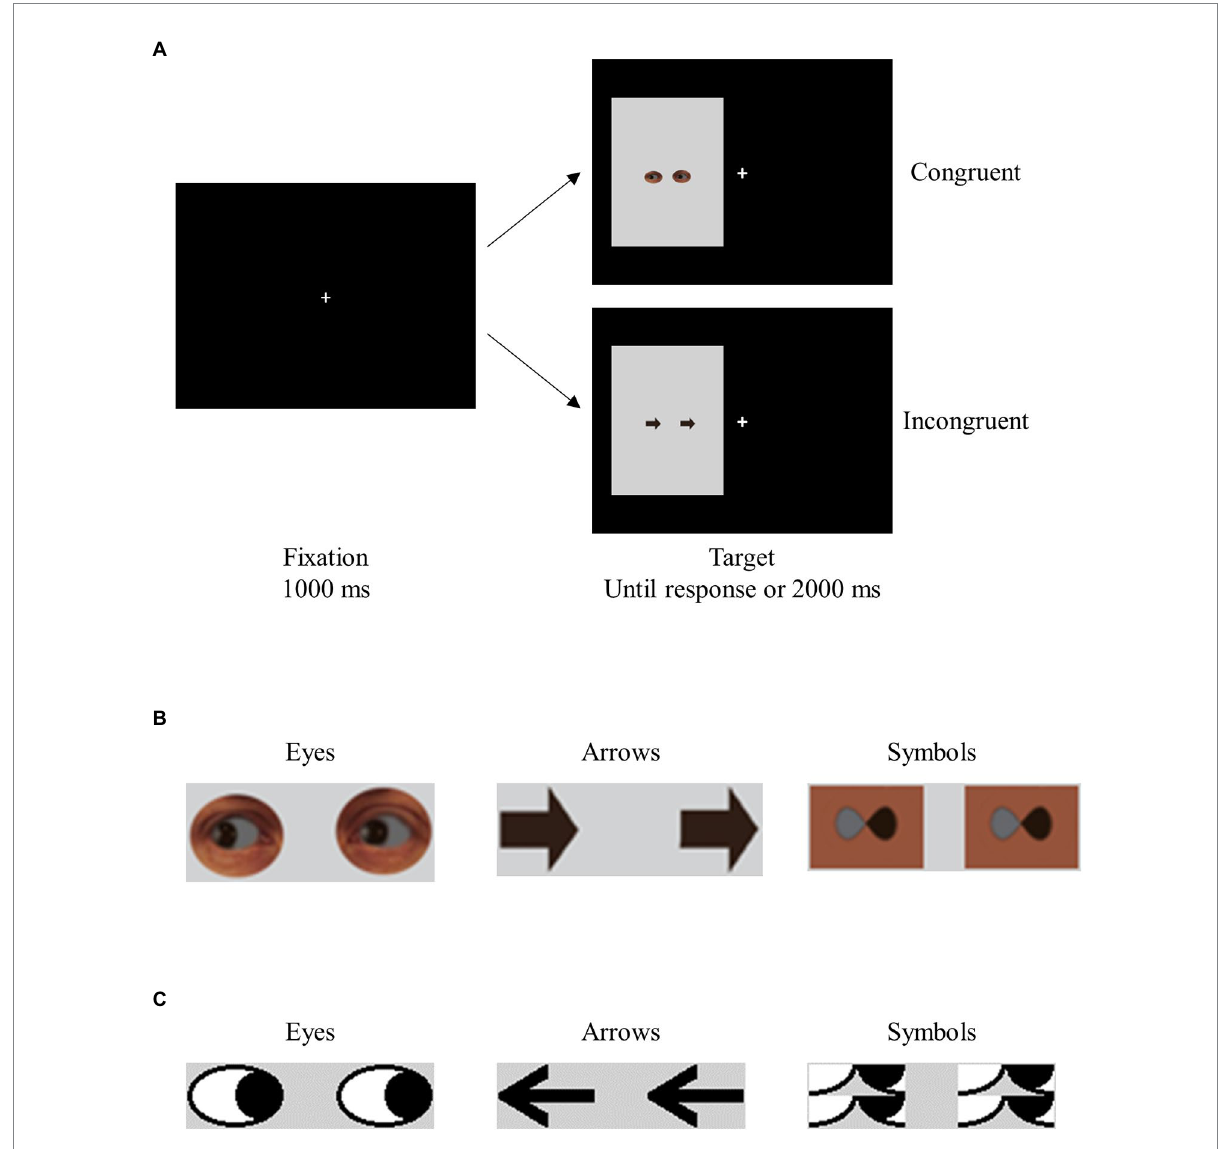
FIGURE 1 Sample trials in Experiment 1 (A) , and sample stimuli in Experiments 1 and 2 (B) and 3 (C)